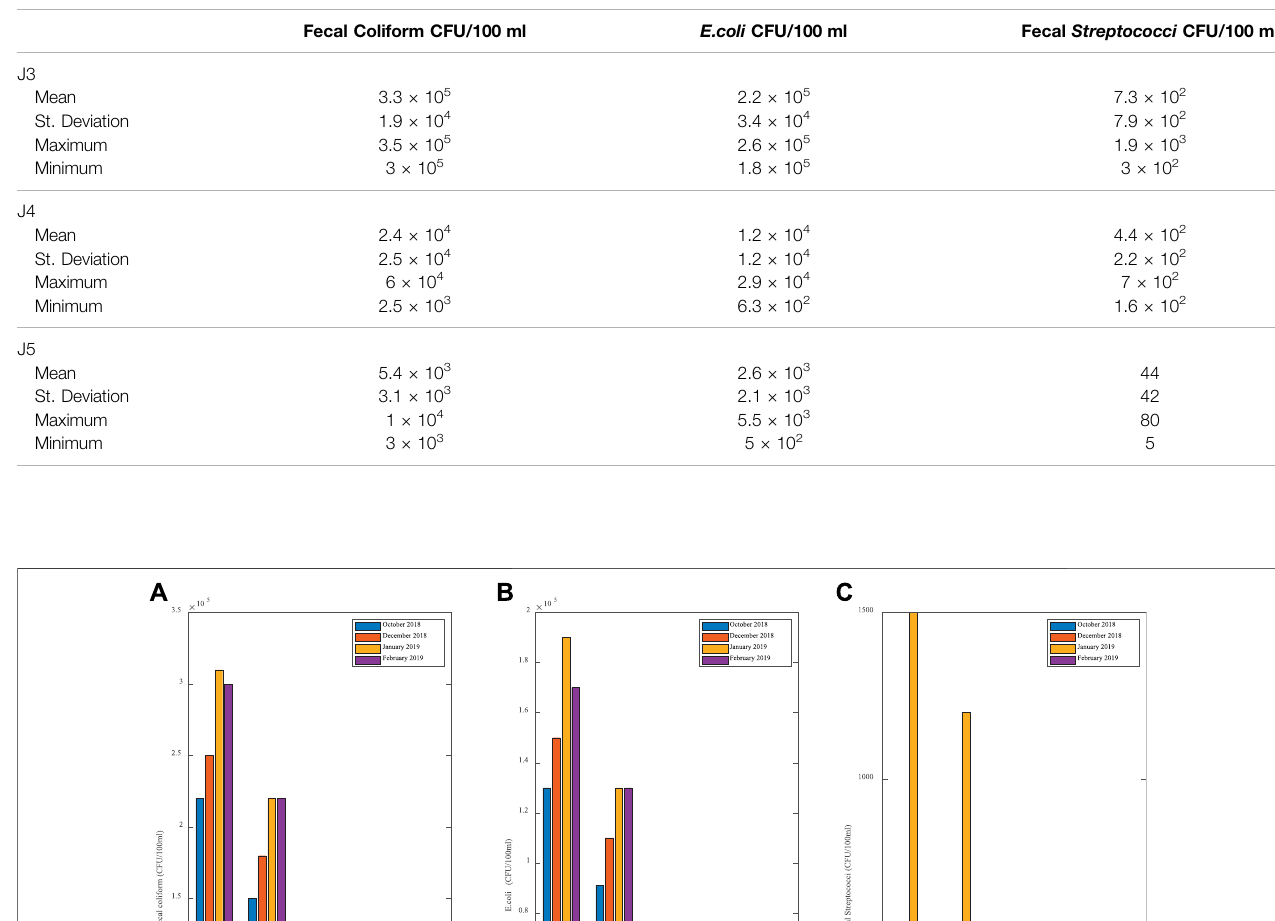
TABLE 6 | Statistical summary of microbial water quality indicators at outfalls J3, J4, and J5.